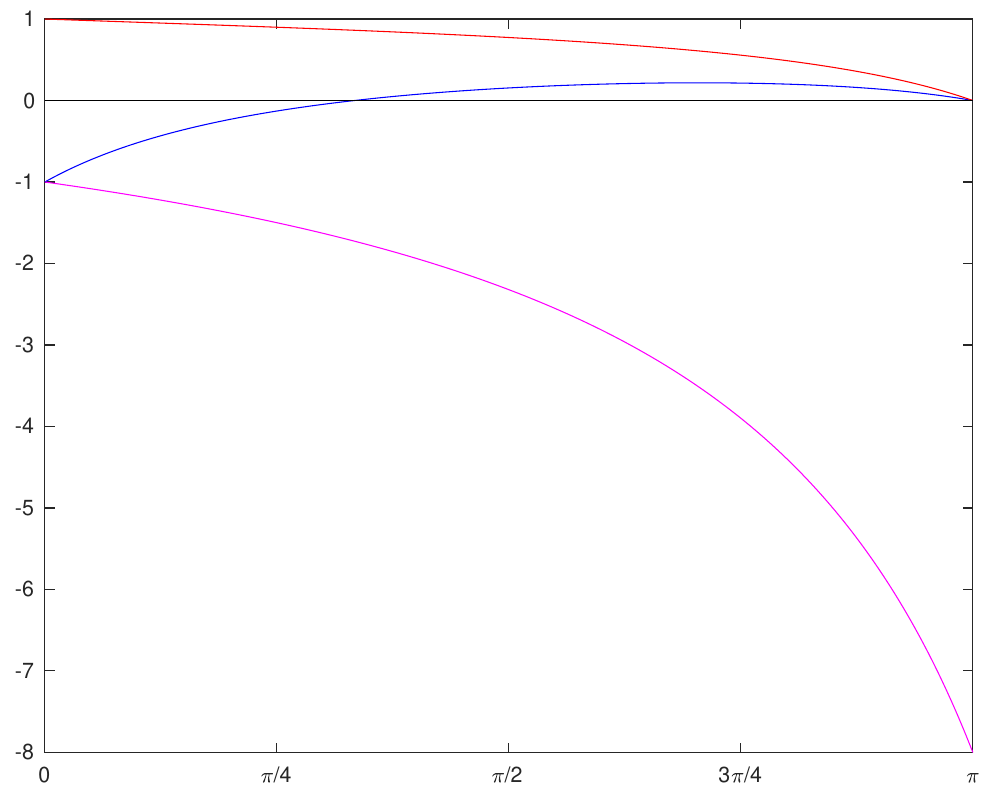
Figure 7. Plot of the maximization results on the imaginary axis of (cid:18) for N = 8. It is easy to see that S (cid:0) (red) has a zero on the imaginary axis at (cid:18) ’ i(cid:25) and S + (blue) has two zeros, one at (cid:18) ’ i(cid:25) and the other at (cid:18) ’ 1 : 048 i . Finally, S I (purple) has no